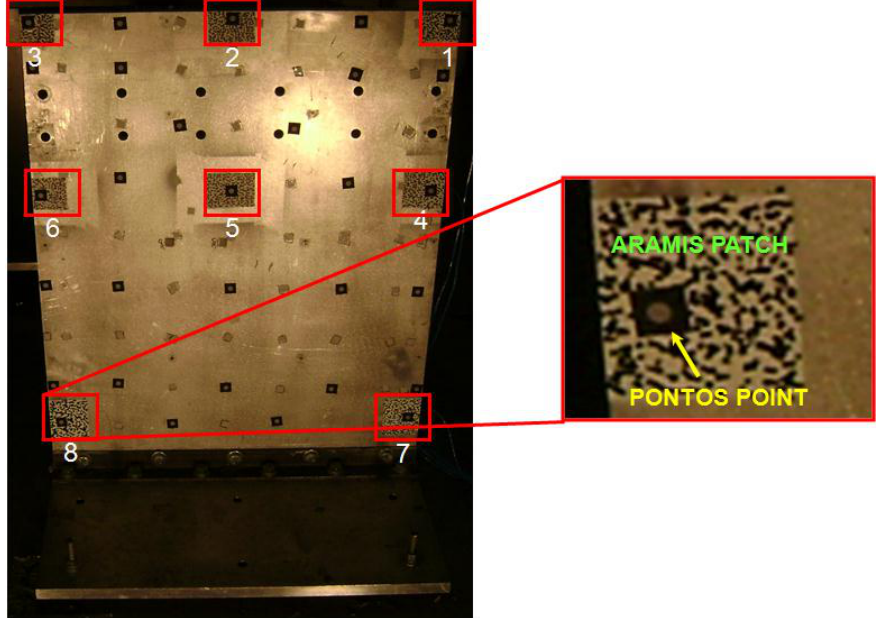
Fig. 10. PONTOS target locations and ARAMIS